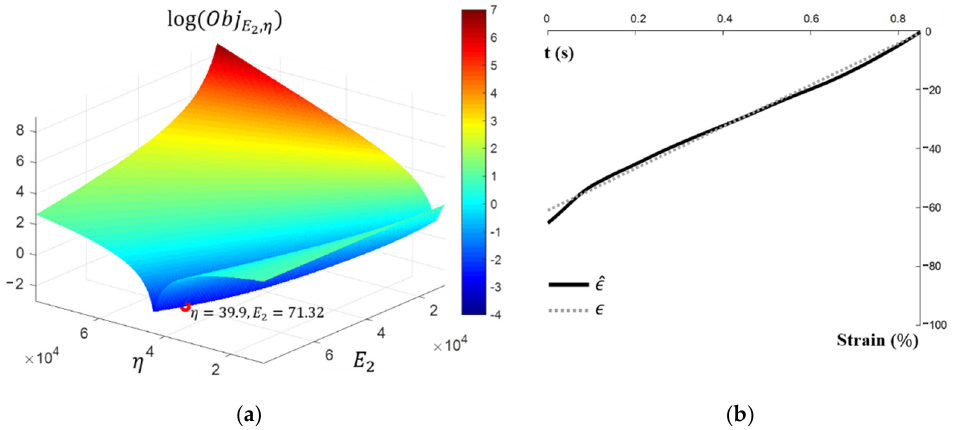
, with respect to E 2 and η (left), whose 2 , η , with respect to (cid:3118) ,(cid:3086)